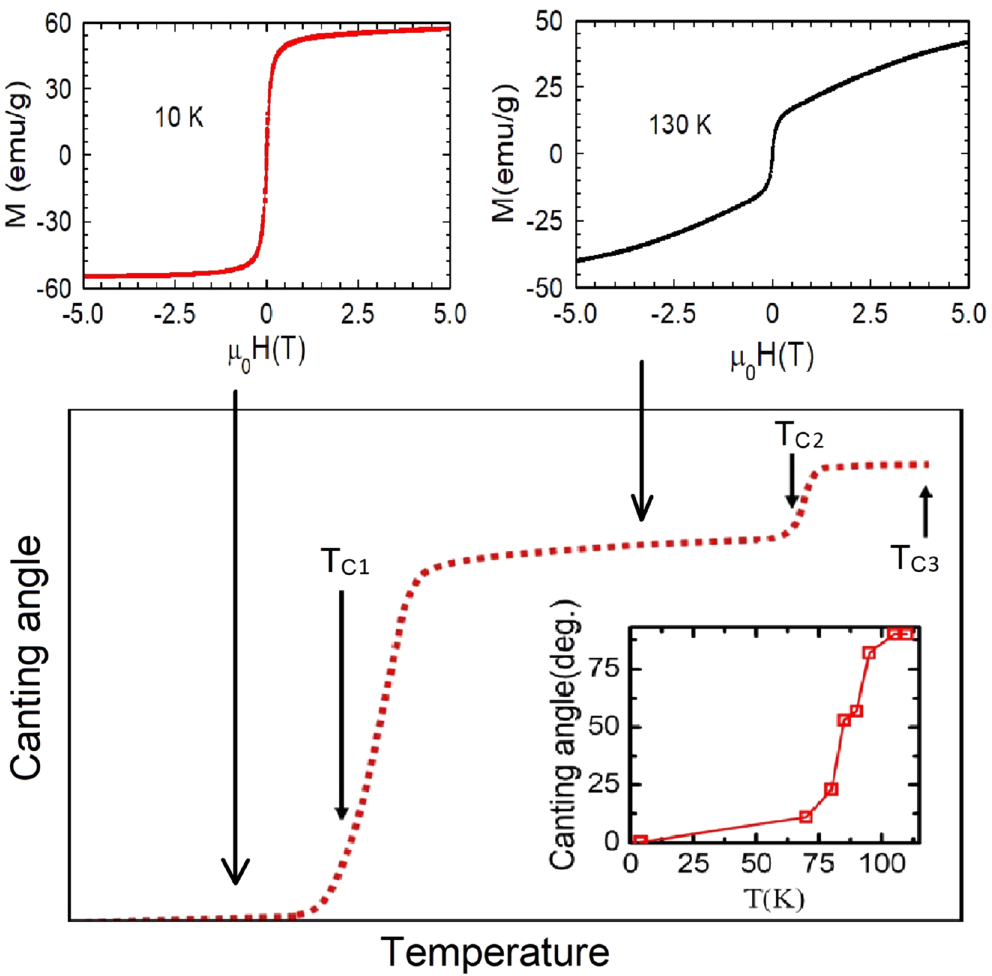
Figure 13. M-H at 10 K (no signature of canting) and at 130 K (canting is clearly observed). Schematic representation of canting angle versus temperature for BL-LSMO-0.3 at normal pressure. Canting angle changes uniformly in a particular phase, however, at and around transition points the canting angle changes fast. Inset is the canting angle with temperature at normal pressure for BL-LSMO-0.315 47 .